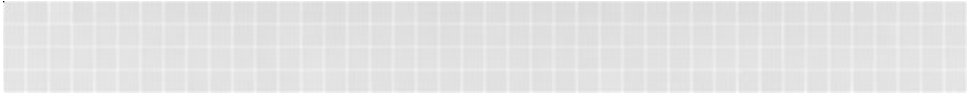
Figure 13. I0-image: 2D projection without